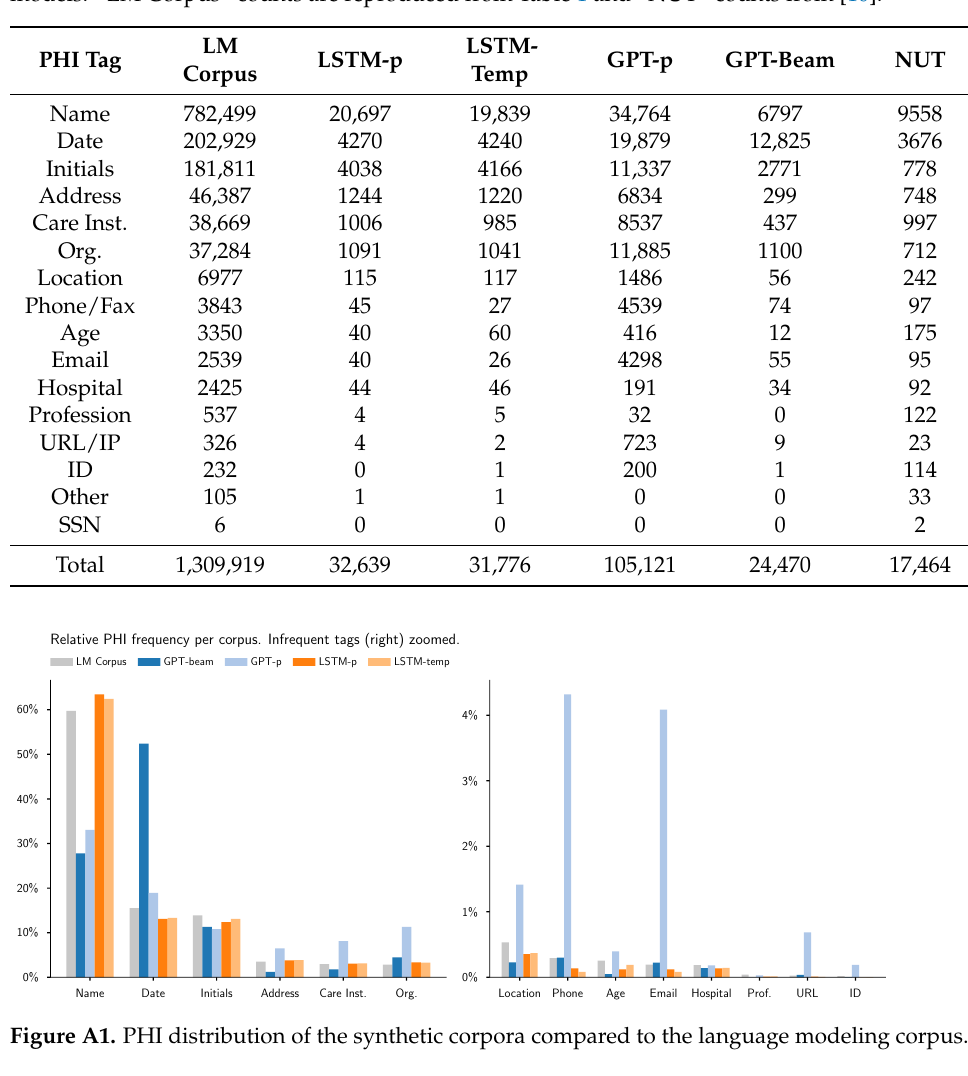
Table A2. Absolute PHI counts in all corpora. The “LM Corpus” is used to develop the language models. “LM Corpus” counts are reproduced from Table 1 and “NUT” counts from [10].